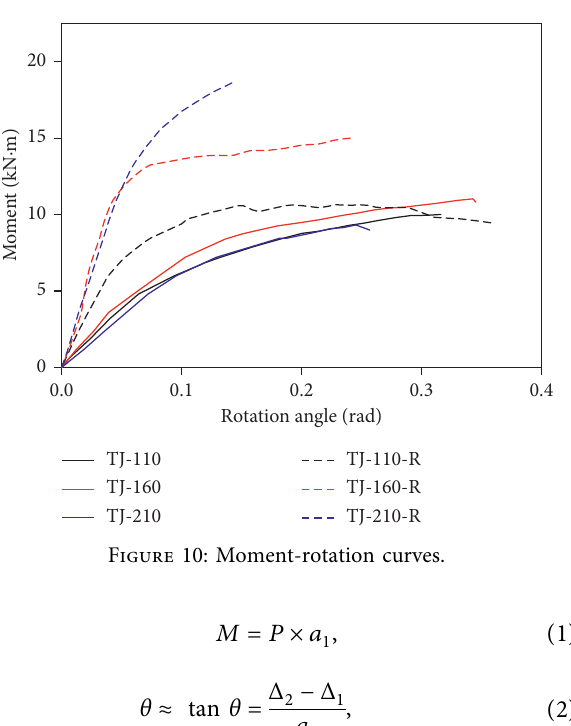
Figure 10: Moment-rotation